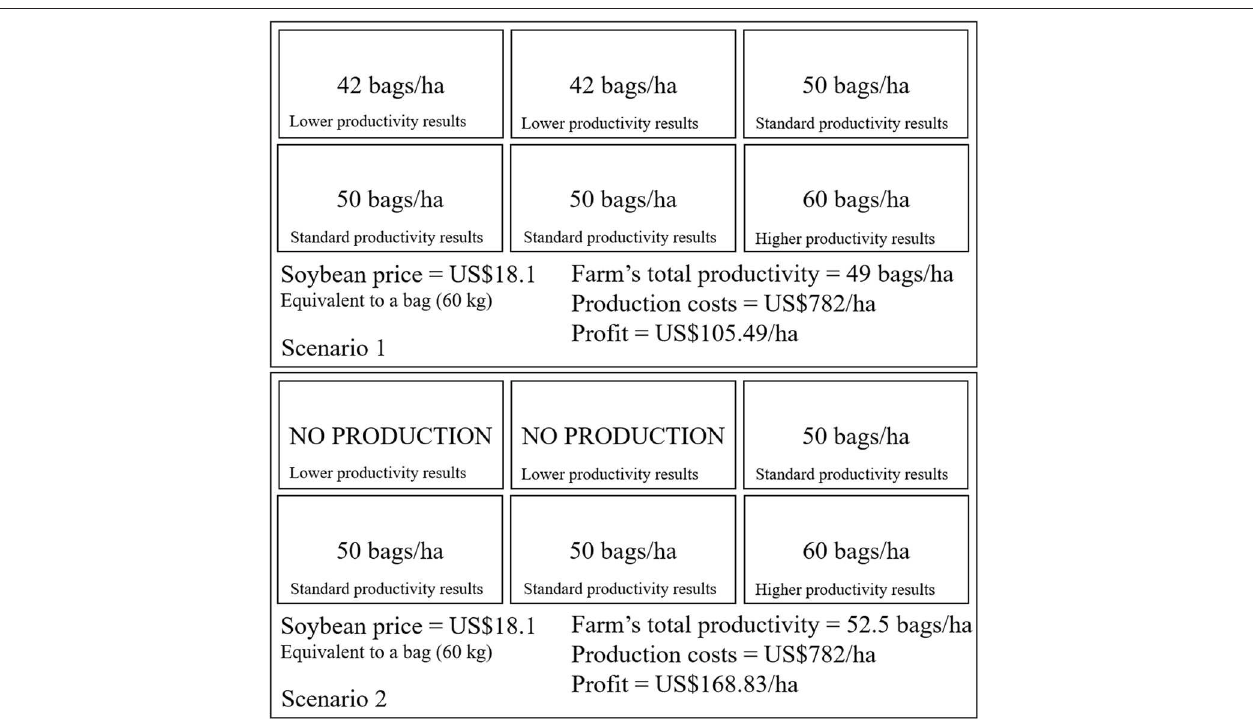
FIGURE 4 | Simulation of a producer’s decision-making process at the farm level to produce soybean in the total area available or only in areas according to historical productivity results. Each bag represents 60kg of soybean—Brazilian